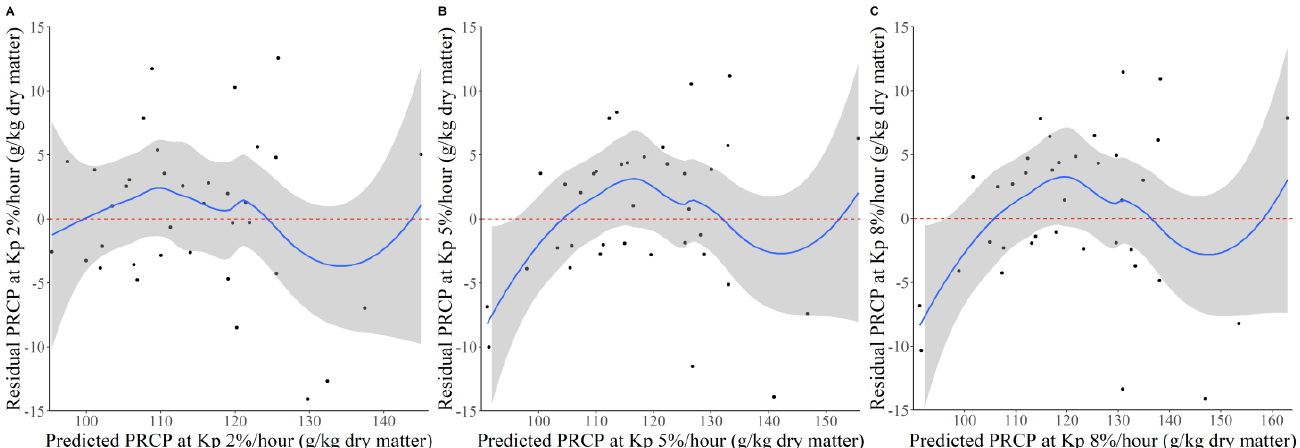
Figure A1. Residuals between post-ruminal crude protein (PRCP) supply estimated with Lebzien et al. [15] equation and PRCP predicted with the developed model versus predicted PRCP supply of tropical forage grasses and legumes at rumen passage rates (Kp) of 2 ( A ), 5 ( B ) and 8 %/h ( C ).